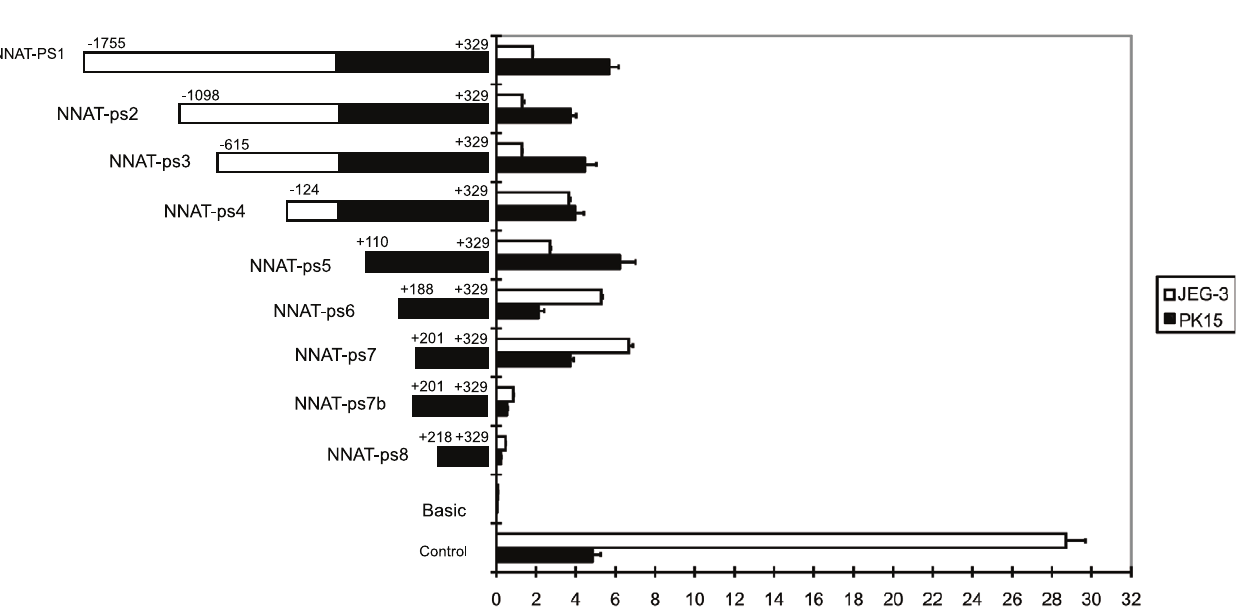
Figure 8. Identification of crucial transcriptional regions of NNAT . Three replicates were used for each vector in each transfection. When two base pairs in the region were mutated from CA into AT (NNAT-PS7b) in square box, the transcriptional activity was reduced to a level similar to the basic control.